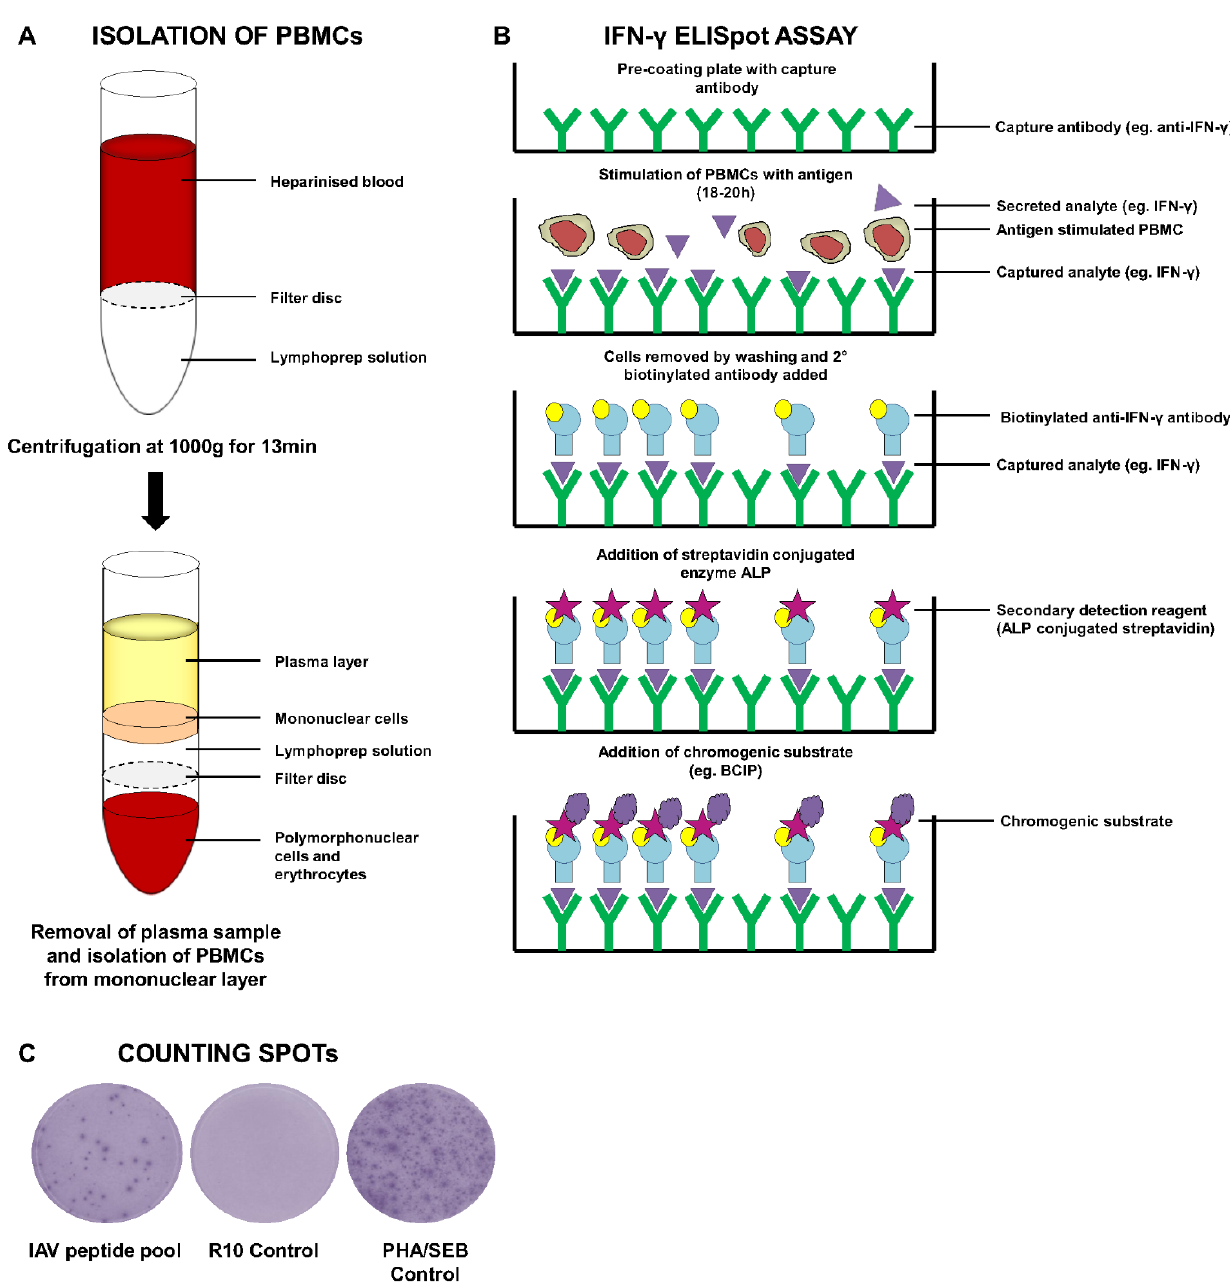
Figure 1. Schematic overview of PBMC isolation for IFN-γ ELISpot Assay. ( A ) Heparinised blood is added to lymphoprep-containing leucosep tubes and samples centrifuged for 13 min at 1000 × g without brake. A plasma sample is taken before mononuclear/PBMCs are collected. Cells are washed and counted before being used for an ELISPOT assay; ( B ) Schematic diagram outlining the methodology behind an IFN-γ ELISpot assay; ( C ) Example of spot forming units following development of an ELISpot assay, showing antigen-specific IAV responses, negative control medium alone (R10) and positive control